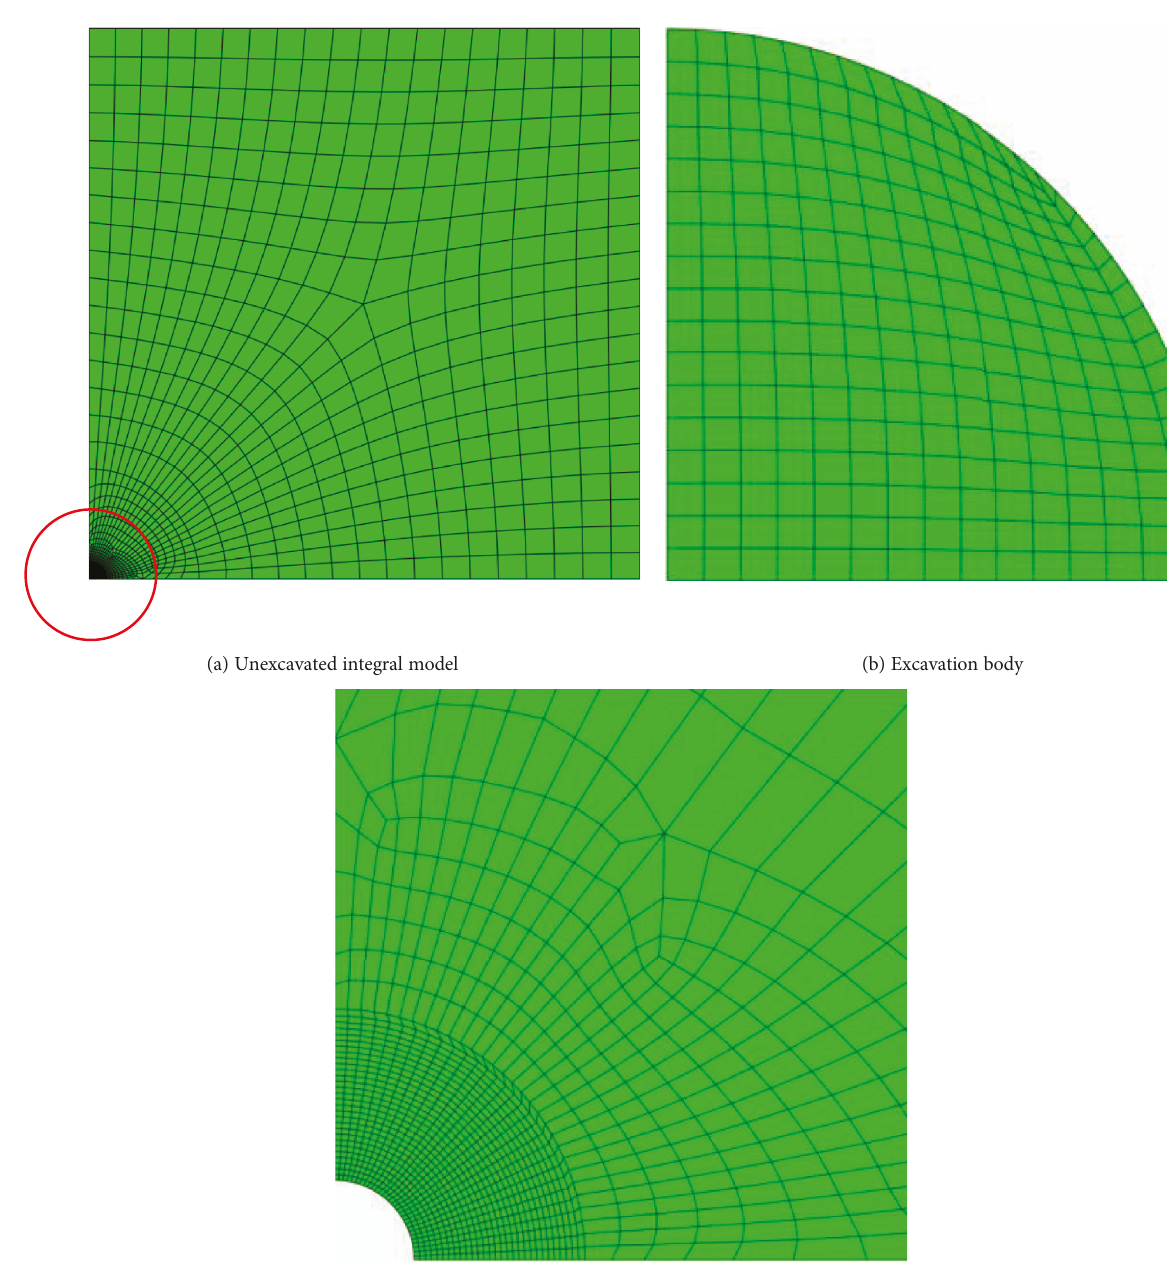
Figure 9: Meshes of the analysis